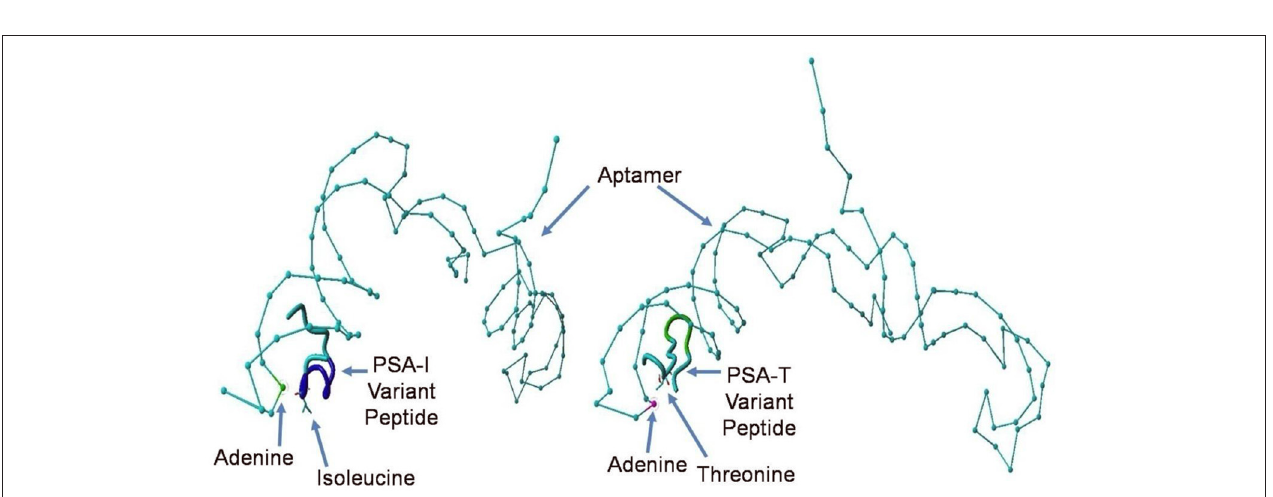
FIGURE 6 | Close up views of the top PSA aptamer binding to both, the I and T peptide variants. This tube structure docking analysis revealed the presence of a common proximal adenine in the aptamer binding site as indicated by arrows directly across from the indicated isoleucine (I) or threonine (T), which could be replaced by a diaminopurine (DAP) base to alter binding in the region and potentially discriminate the I- vs. T-PSA peptide